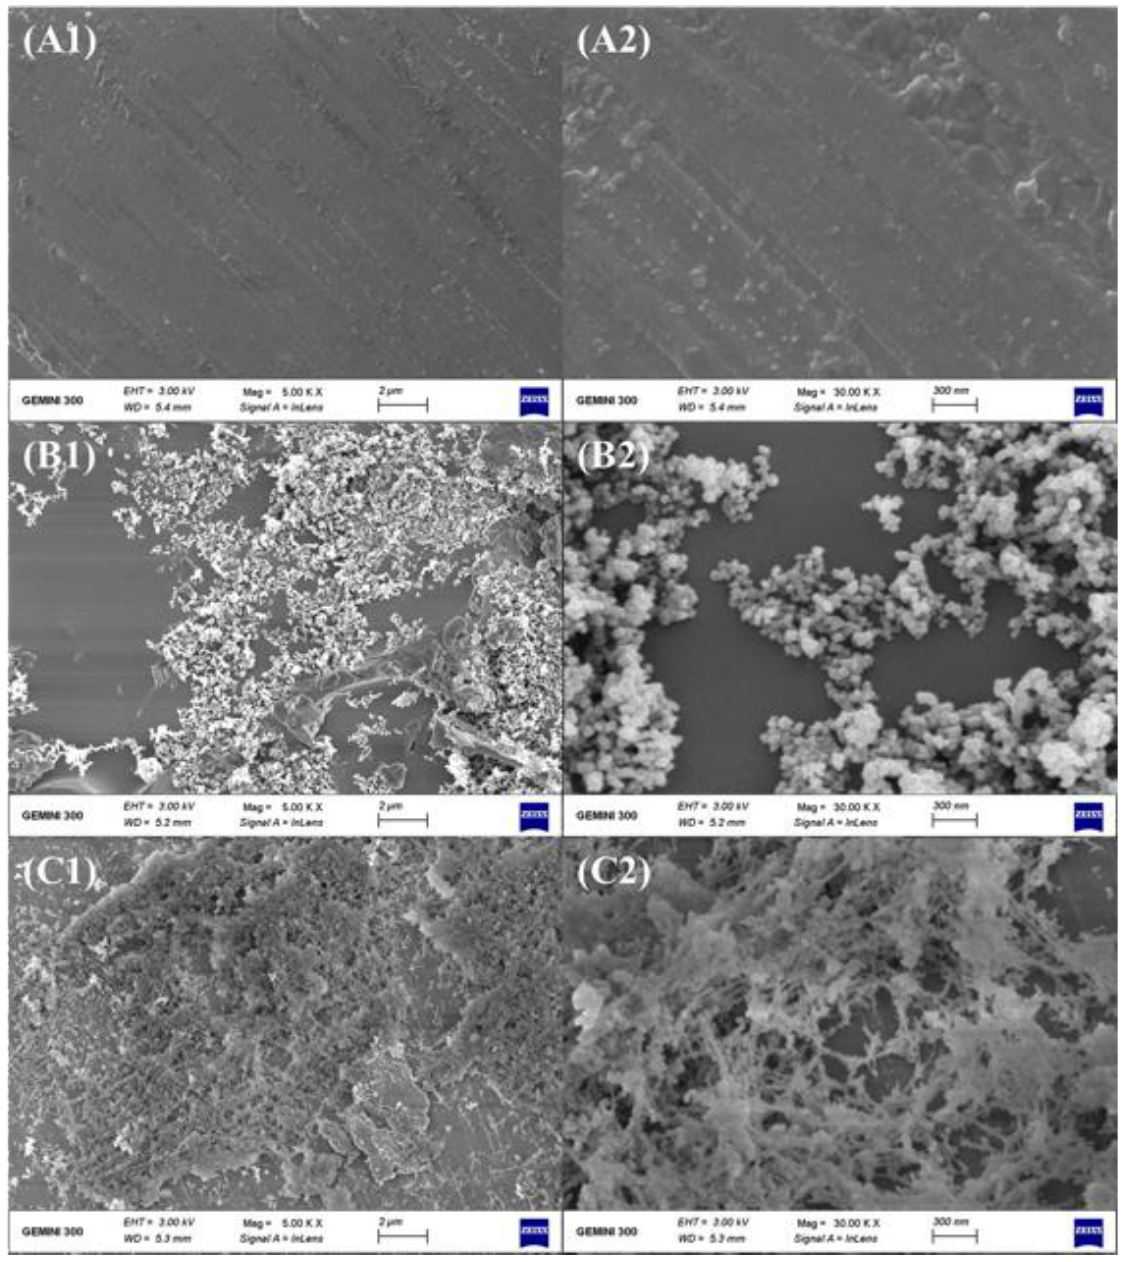
Figure 9. SEM images of soot aggregates that remained on the zirconia ceramic rod. Photographed with a GeminiSEM 300 (produced by Carl Zeiss Jena, Germany): ( A1 , A2 ) blank sample; ( B1 , B2 ) JP-10, 900 K; ( C1 , C2 ) 0.5% HPE-blended JP-10, 900 K.